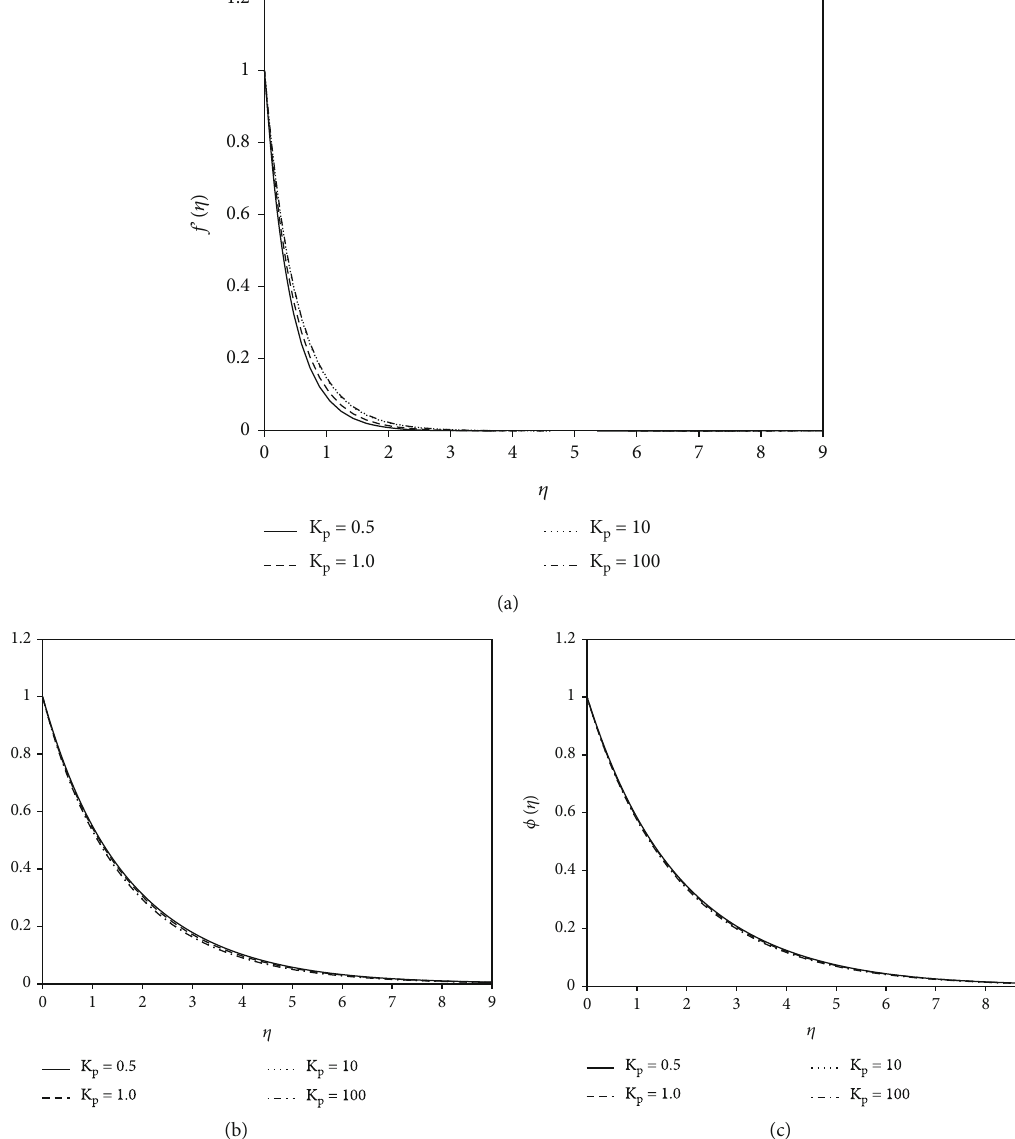
on the temperature pro fi le. p